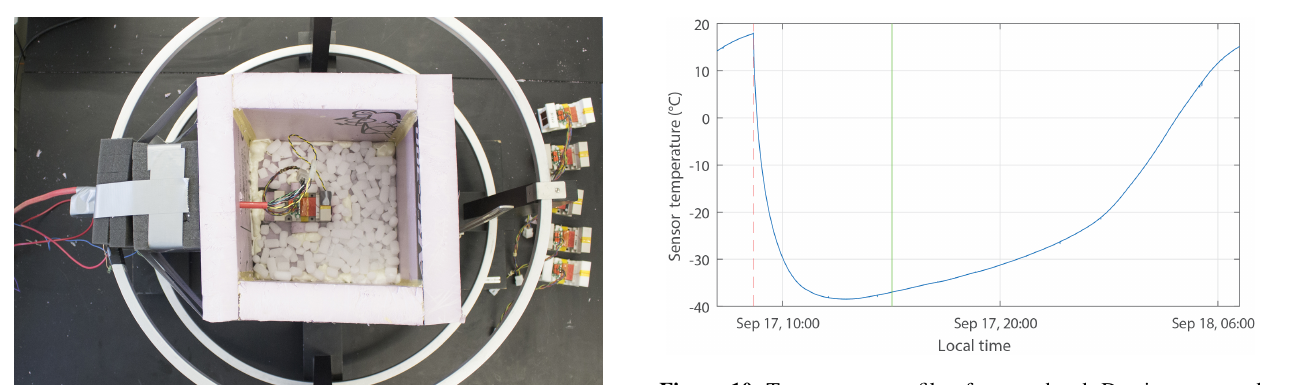
Figure 10. Temperature profile of sensor head. Dry ice was used to chill the sensor (dashed red line), and measurements were taken after the dry ice had sublimated and the sensor was slowly warming (solid green